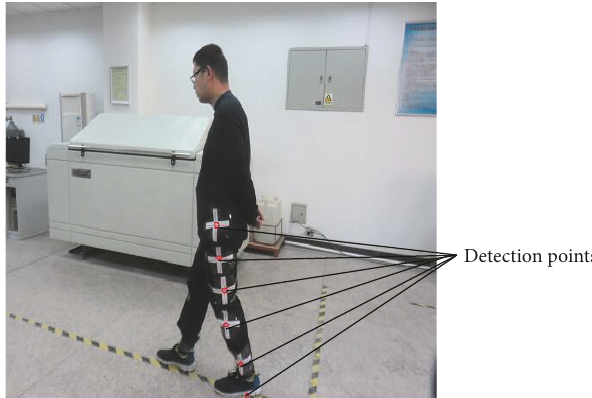
Figure 10: Data acquisition location of a